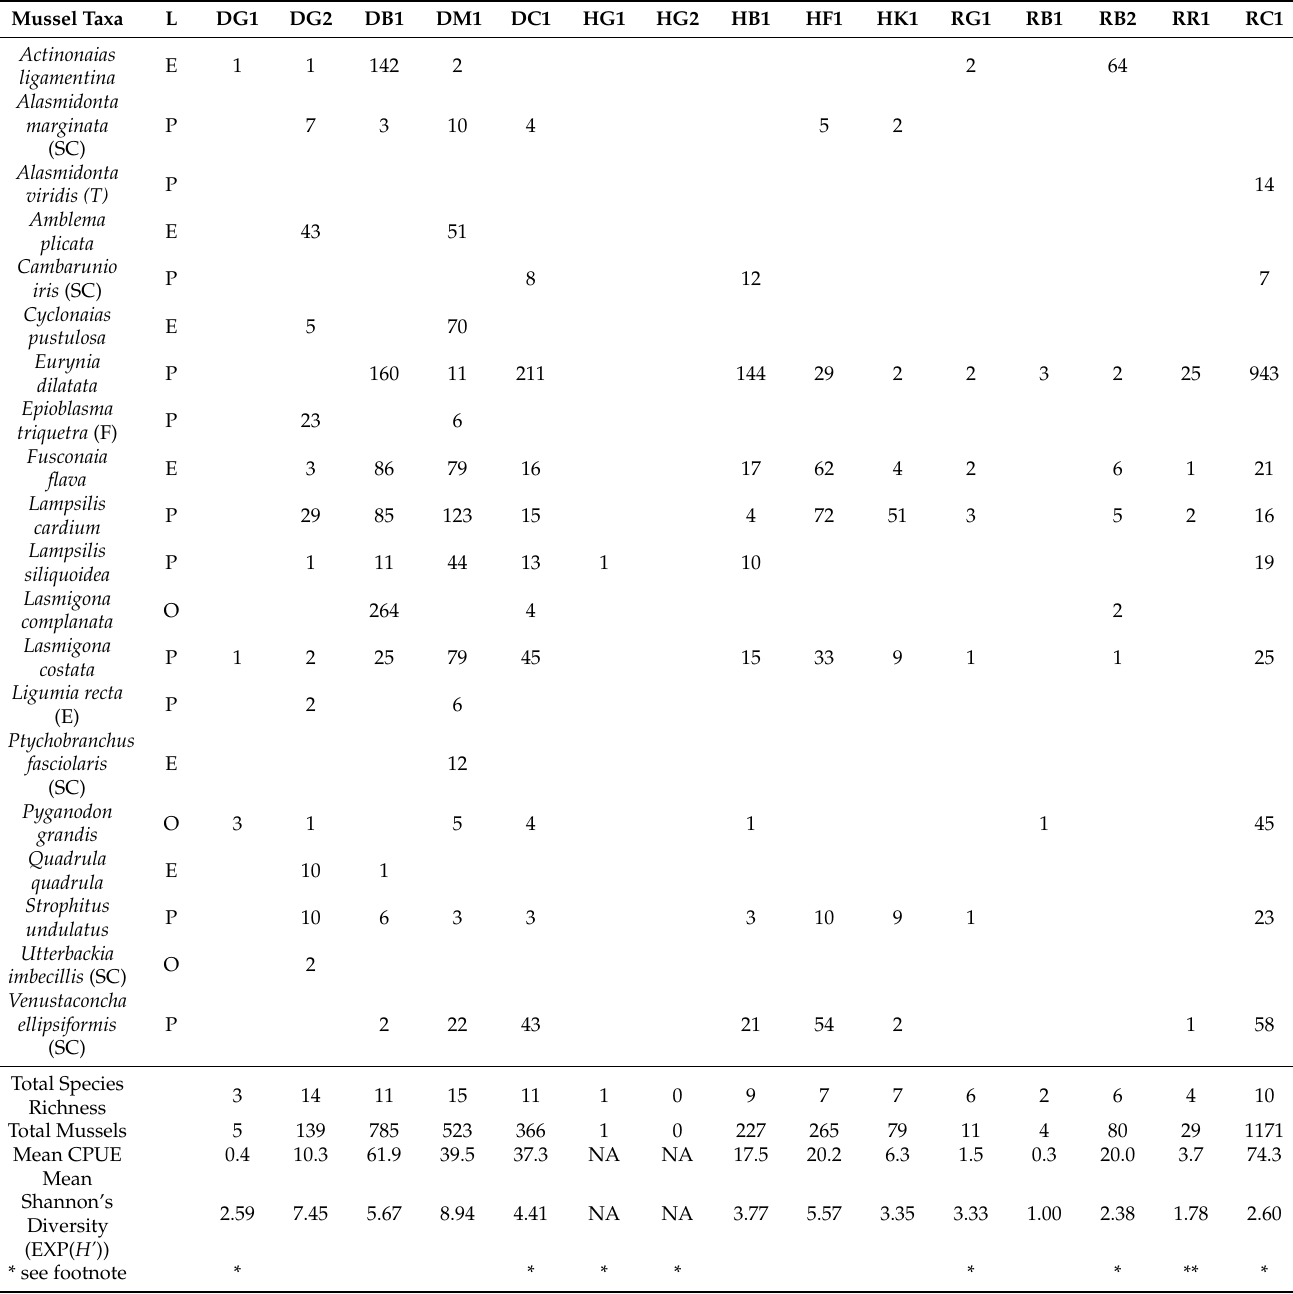
Table 1. Mussel assemblage metrics collected within timed-searches and quadrats downstream of fifteen sites in the Lake Michigan basin, Michigan, USA. State mussel status is E = endangered, T = threatened, SC = special concern. Federal mussel status is F = endangered. Life-history strategy (L) is E = Equilibrium, P = Periodic, O = Opportunistic